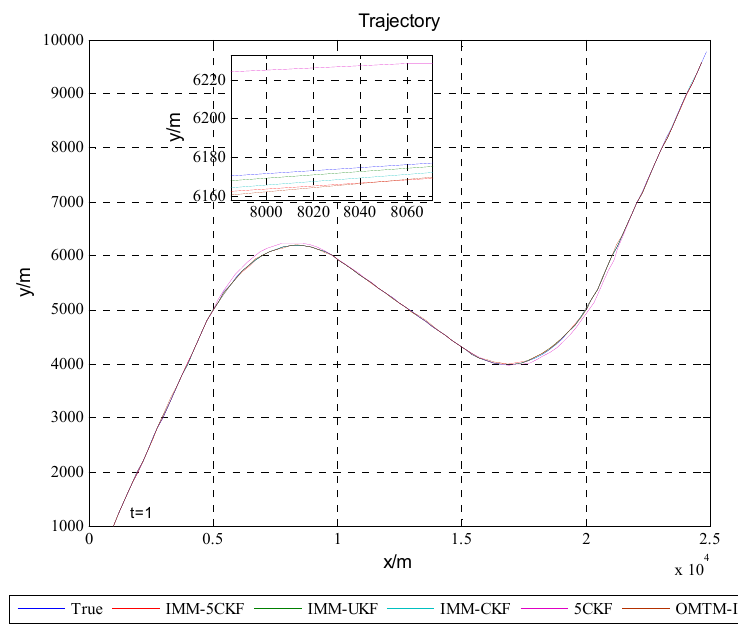
Figure 2. Target Trajectory.